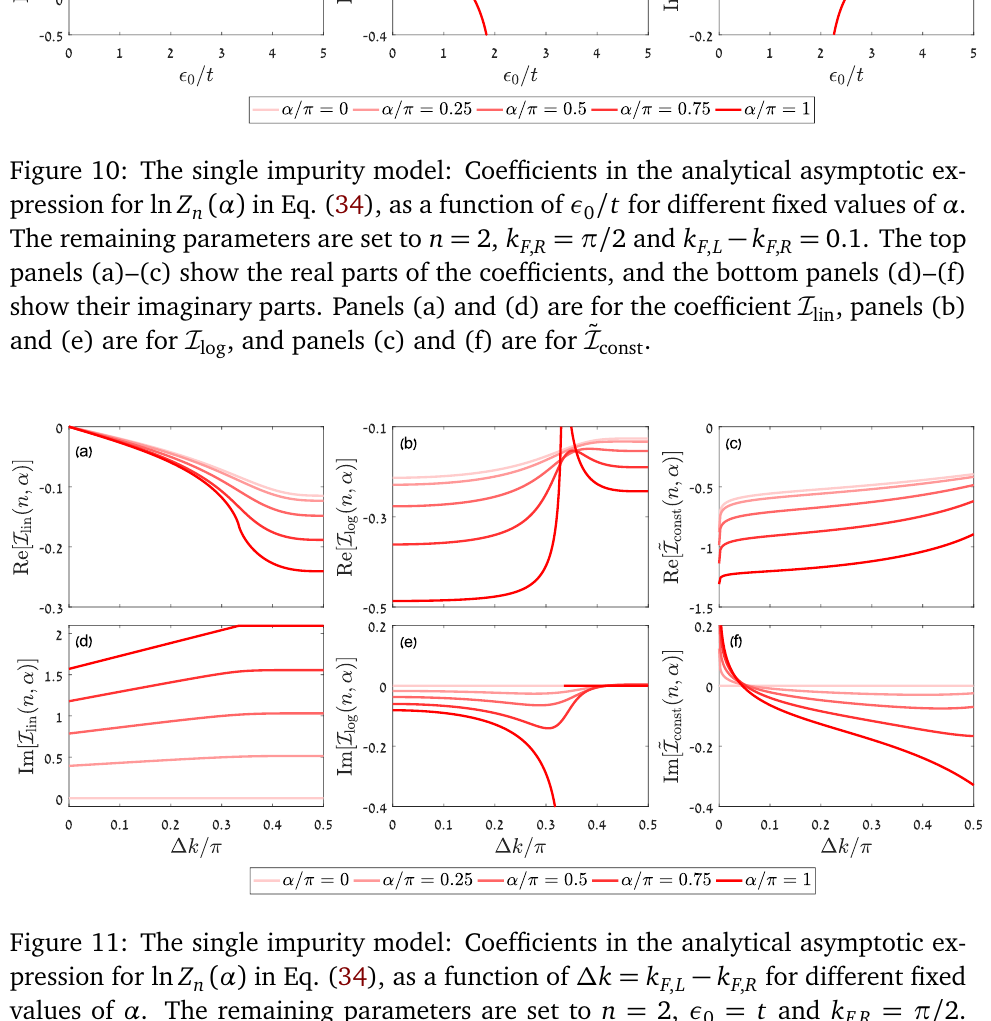
− k for different fixed F , L F , R = t and k = π/ 2. F , R 0 , lin const